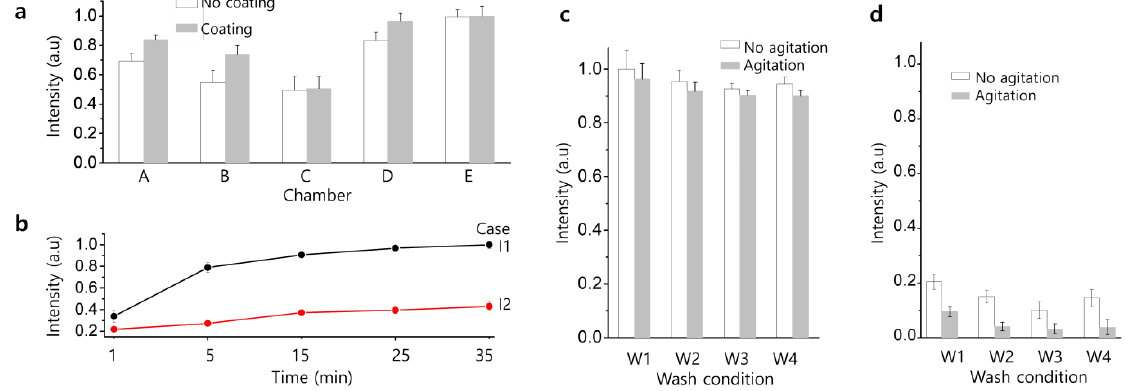
Figure 3. Characterization of on-chip sandwich immunoassay. Error bars are S.D. for n = 3. ( a ) In- fluence of the chamber material on virus detection. Chambers A – D are 3D-printed with different materials, and chamber E is a commercial polypropylene tube. ( b ) Effect of the incubation time and agitation on the binding between the MBs and the virus particles in Step 1 of Figure 2. Cases I1 and I2 represent continuous agitation and agitation for the first 6 s, respectively. ( c ) Influence of the washing procedure in Step 4 to remove the background signal noise for virus detection. The fluorescence intensities are shown with the virus in ( c ) and without the virus in ( d ). Under conditions W1, W2, and W3, one, two, and three chambers of B4 with a 70 μ L volume each are used, respectively, and under condition W4, one chamber of B4 with a 210 μ L volume is used.